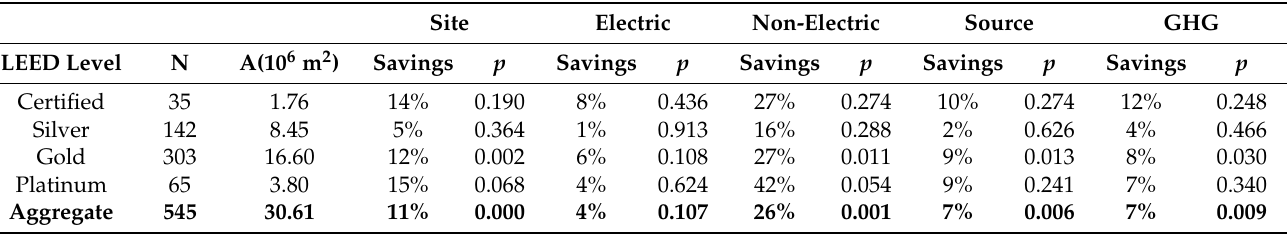
Table 4. LEED savings in the five intensity metrics relative to the area weighted means for non-LEED offices in the same cities. The p -values are 2-sided, calculated using permutation testing with 10,000 replicates. Site Electric Non-Electric Source